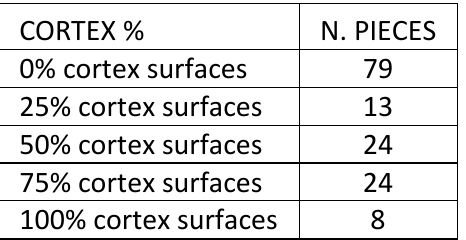
Figure 3. Garumnian cherts characteristics. A) Macroscopic view. B) Microscopic view. C) X-Ray diffractogram. Blue line: quartz (89,9%); Pink line: muscovite (10,1%). Table 1. Presence of cortex in chert